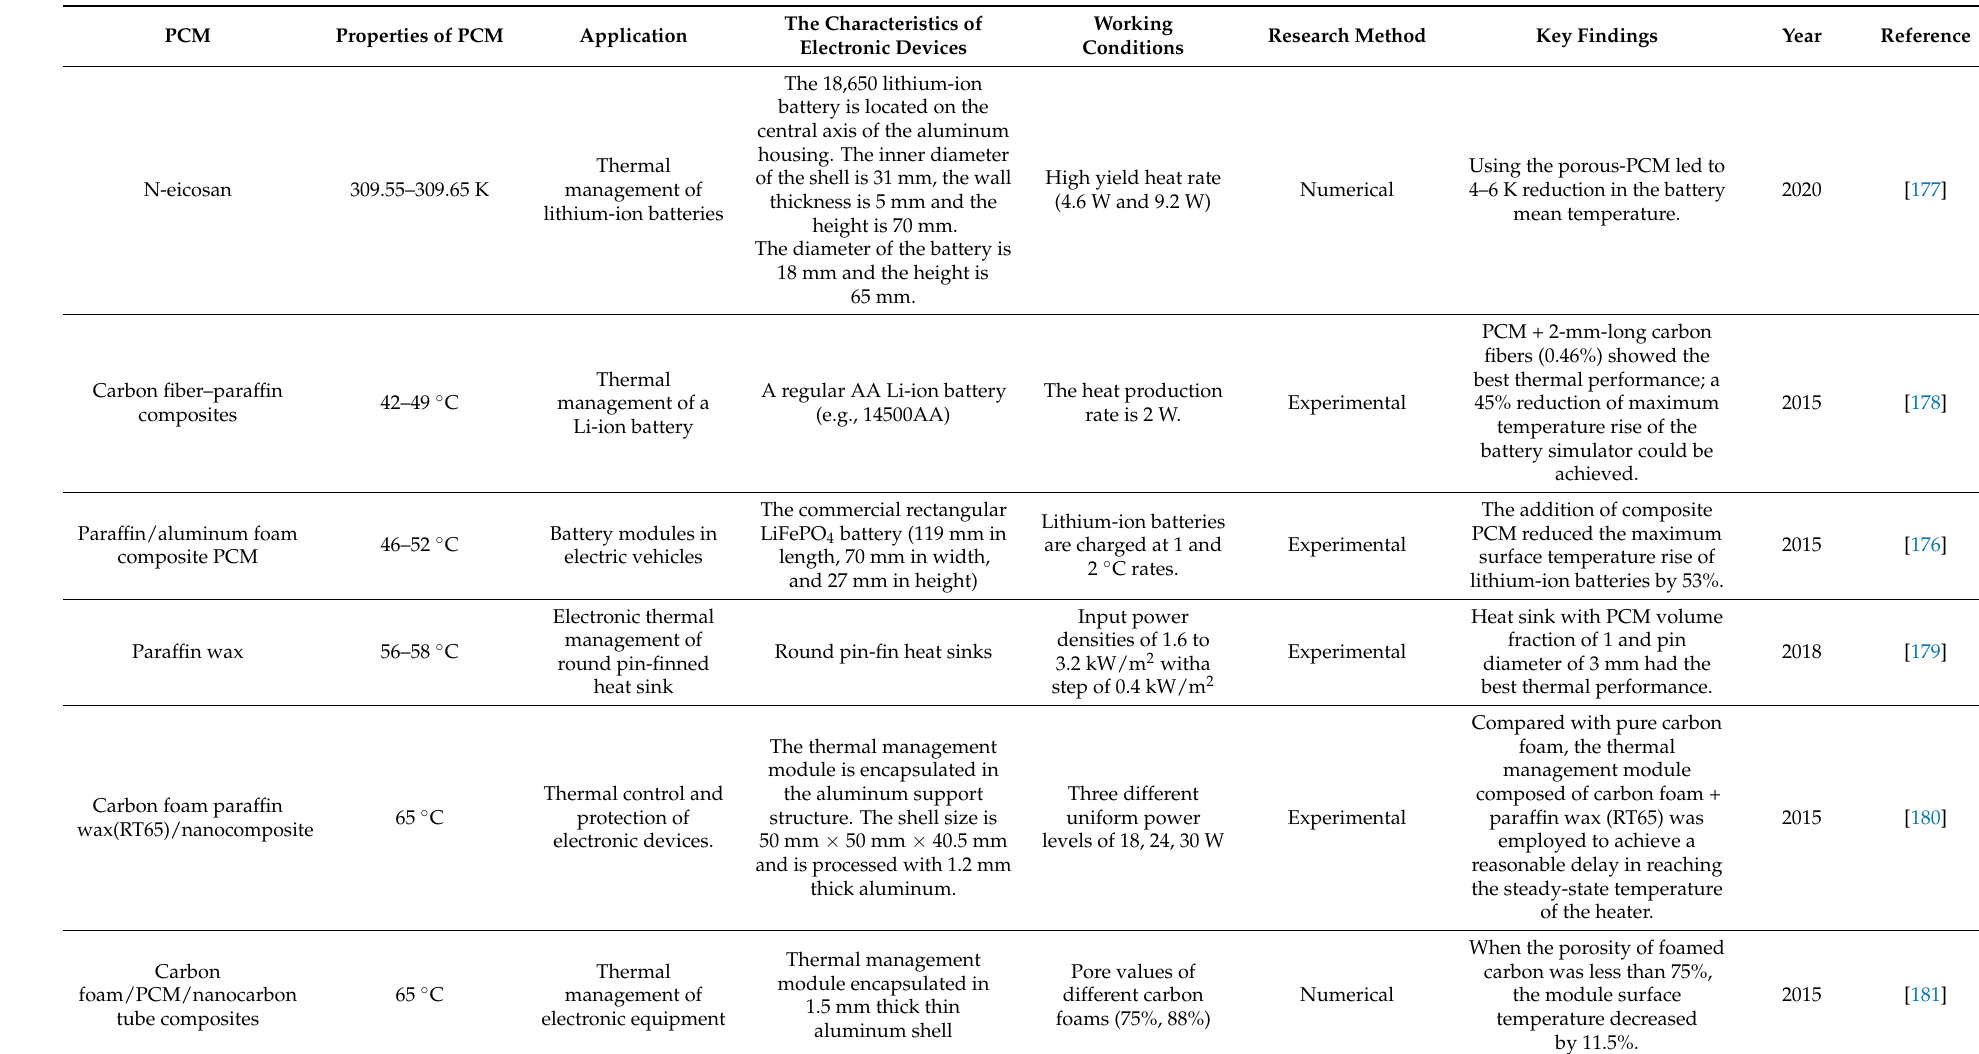
Table 12. Typical applications of cold storage PCMs in thermal management of electronic